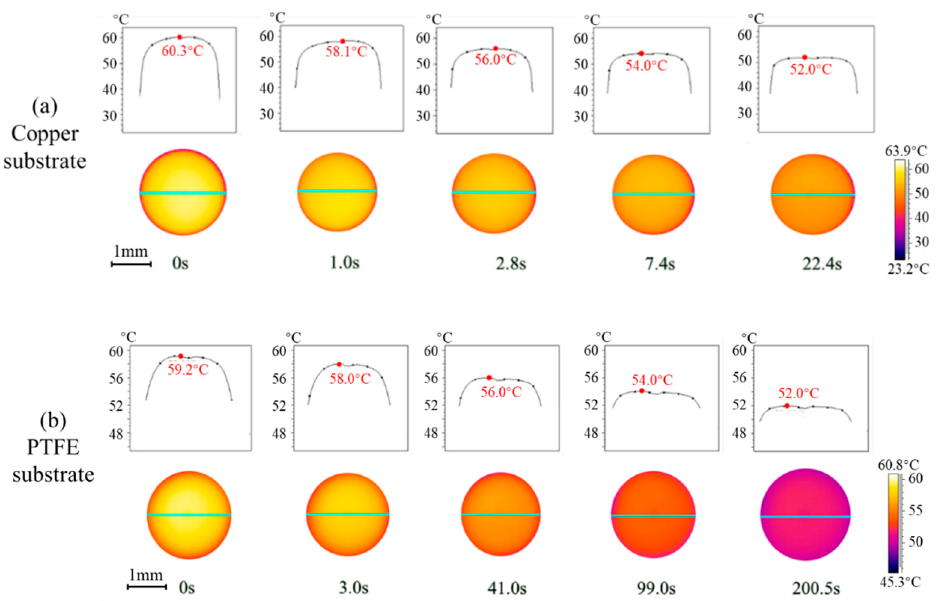
Figure 5. Spatiotemporal evolution of interfacial temperature of LiBr-H 2 O droplets on ( a ) copper and ( b ) PTFE substrates coated with FEP.